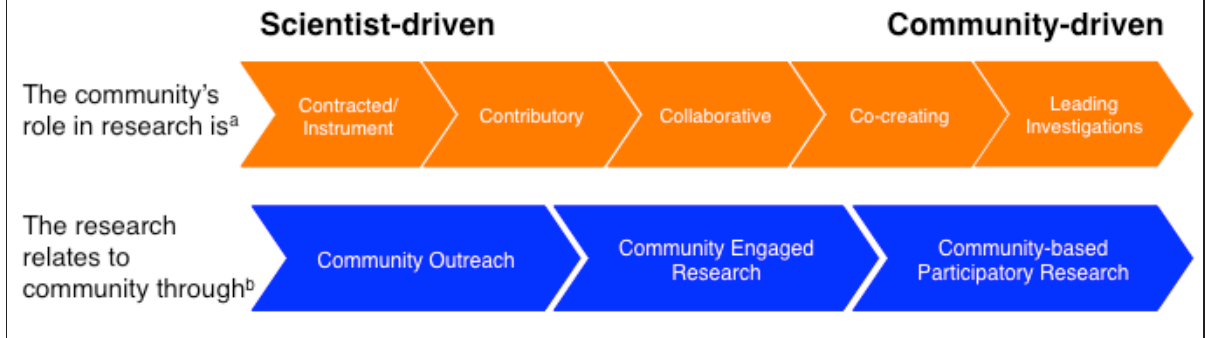
Figure 2: Examples of terminology commonly used to describe different forms of research partnerships between the public and professional scientists. a